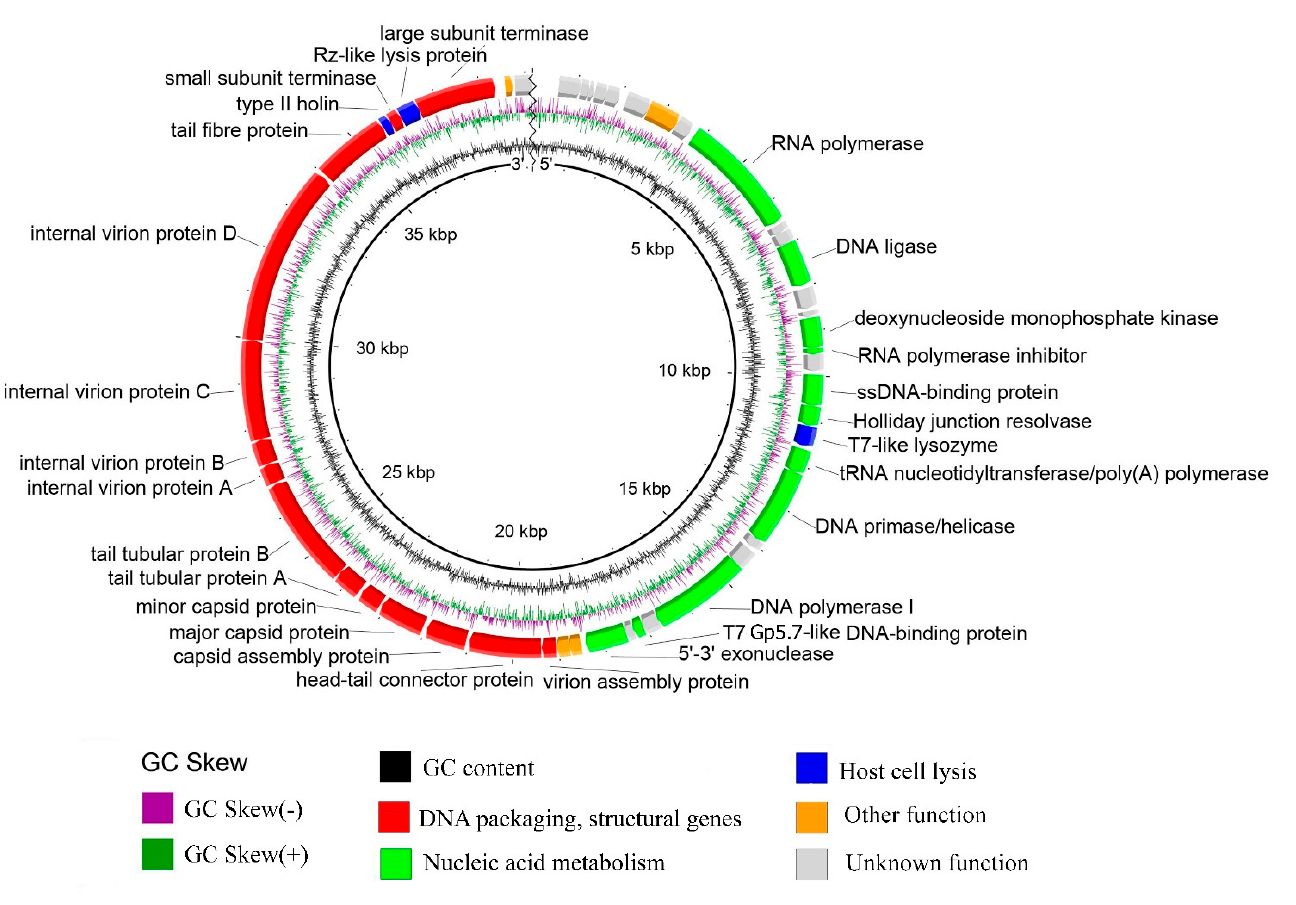
Figure 6. Pseudomonas phage Pf-10 genome map. Functionally assigned ORFs are highlighted according to their general functions (see the legend).